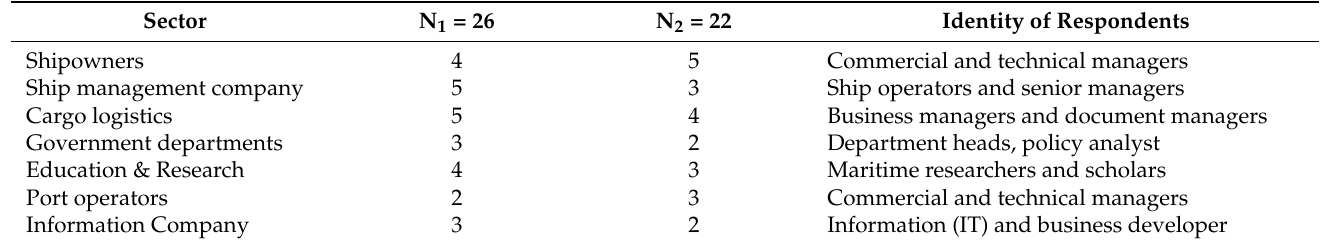
Table 1. List of Participants (N 1 : Semi-structured interviews, N 2 : Conversational interview). Sector Identity of